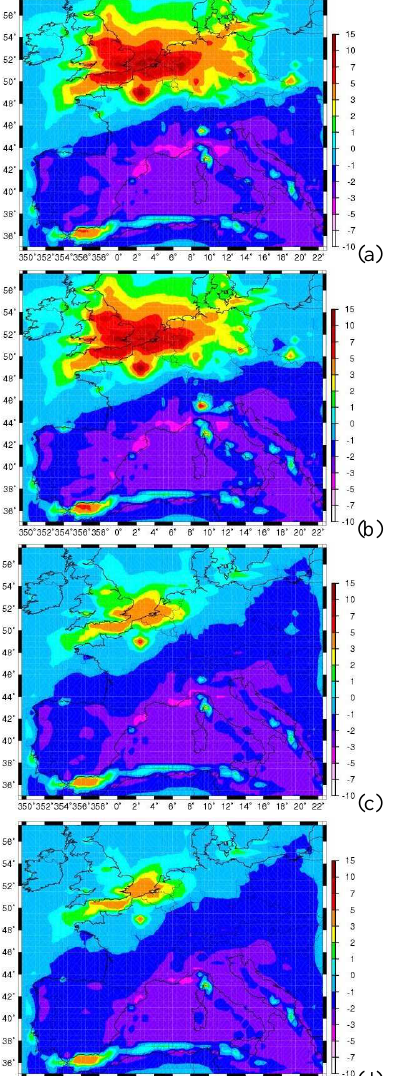
Fig. 8. Chemical regime simulations with respect to daily ozone maximum for summer 2001 meteorology, but for (a) 1980, (b) 1990 emissions, (c) 2010, (d) 2020 emission